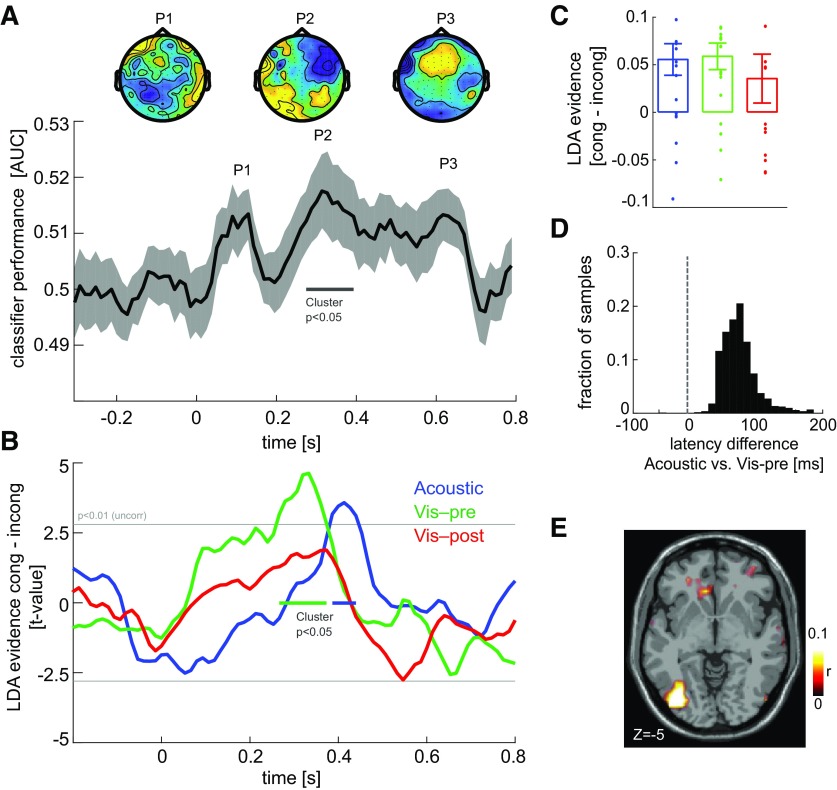
Electrophysiological correlates of cue–stimulus congruency. A, Single-trial LDA was used to determine EEG components sensitive to the direction of random-dot motion, that is, sensitive to the task-relevant visual information. The curve shows the classifier performance as the area under the curve of the receiver operating characteristic (mean and SEM across participants), which was significant (cluster-based permutation test, p < 0.05) ∼300 ms (peak at P2). The topographies show the forward models of the LDA classifiers at three local peaks. B, Effect of cue–stimulus congruency on the single-trial LDA evidence in the component derived at time P2, separately for each cue condition and shown as the group-level t value. Epochs with a congruency effect are indicated (cluster-based permutation test, p < 0.05). C, Congruency effects on LDA evidence at the time points of the respective global peaks (mean and SEM across participants). D, Test for a latency difference of the congruency effect in the acoustic and visual preconditions. The graph shows the group-level bootstrap distribution (2000 samples) of the latency difference between the congruency effects. E, Source localization of the LDA component (at P2) determined as source-level correlation (z-scored) between gridwise activity and the LDA activity (group averaged; shown at MNI coordinate z = −5).